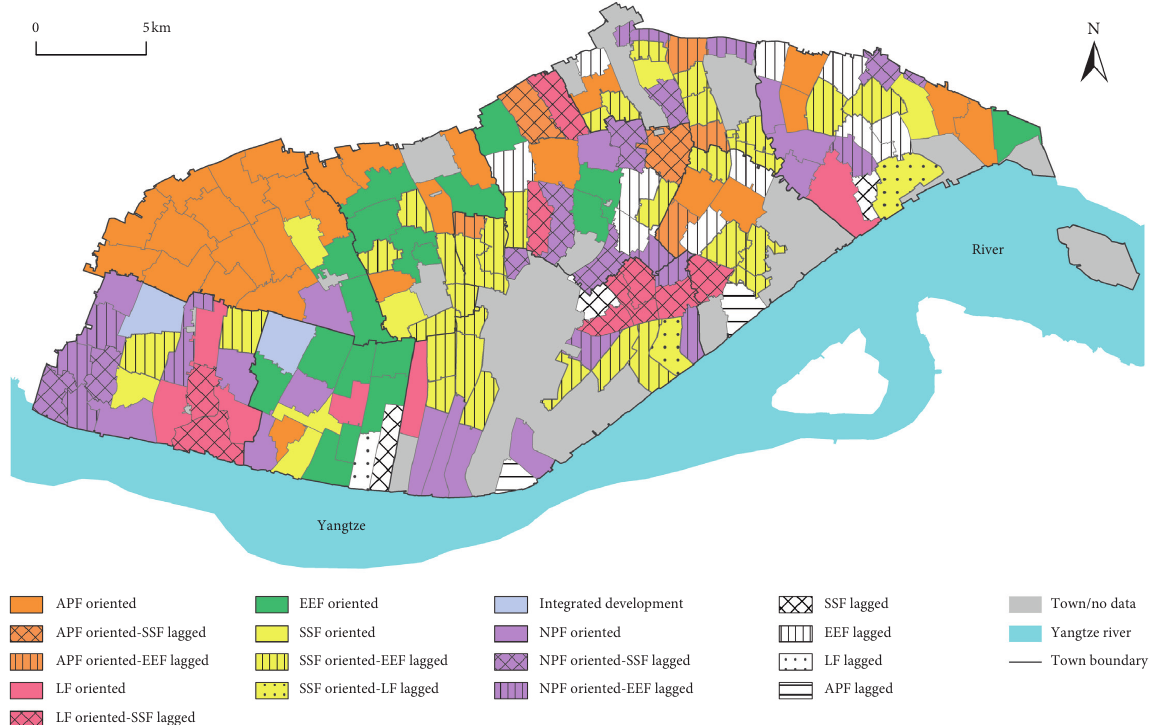
Figure 6: Types of the rural multifunction